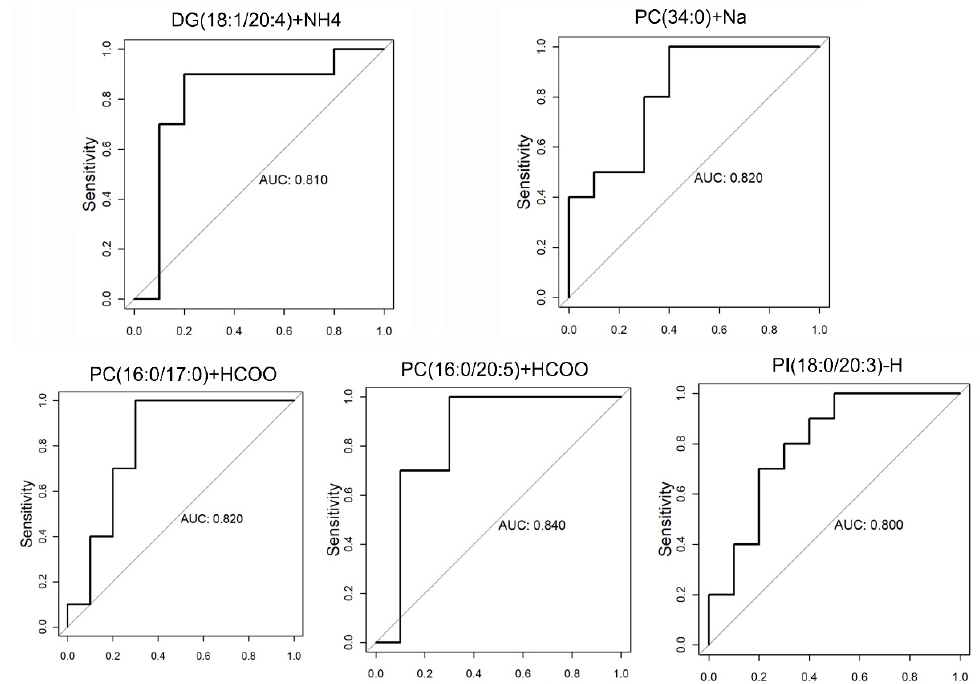
Figure 3. Receiver operating characteristic (ROC) curves for the five significantly expressed metabolites, with an area under the ROC curve of equal to or greater than 80%.